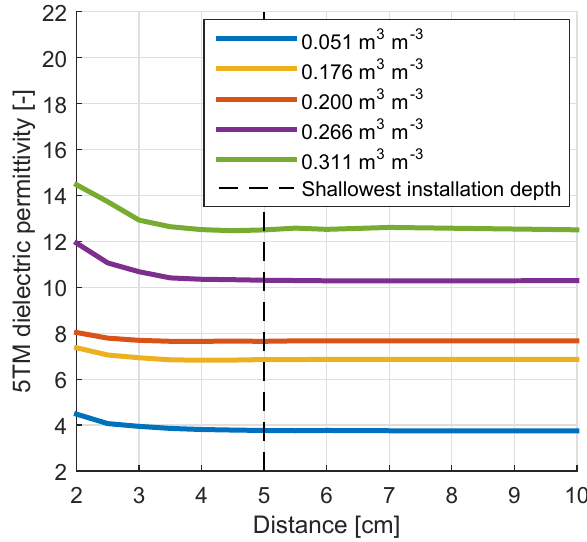
Figure 6. Dielectric permittivity readings of a 5TM sensor in a soil sample from station 1, obtained by moving a steel knife towards the sensor. The lines are the average of measurements obtained by performing the procedure described in Sect. 3.3 five times for each of the soil moisture